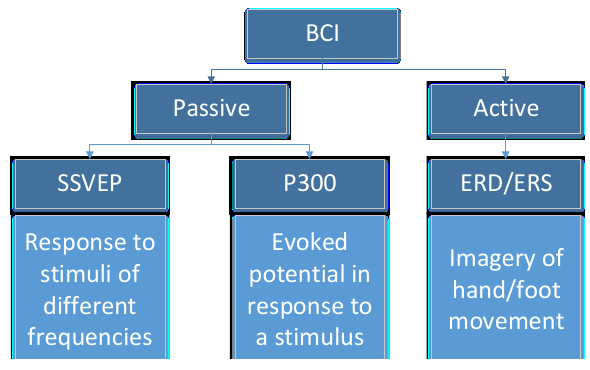
Fig. 2. Classification of BCIs [7].